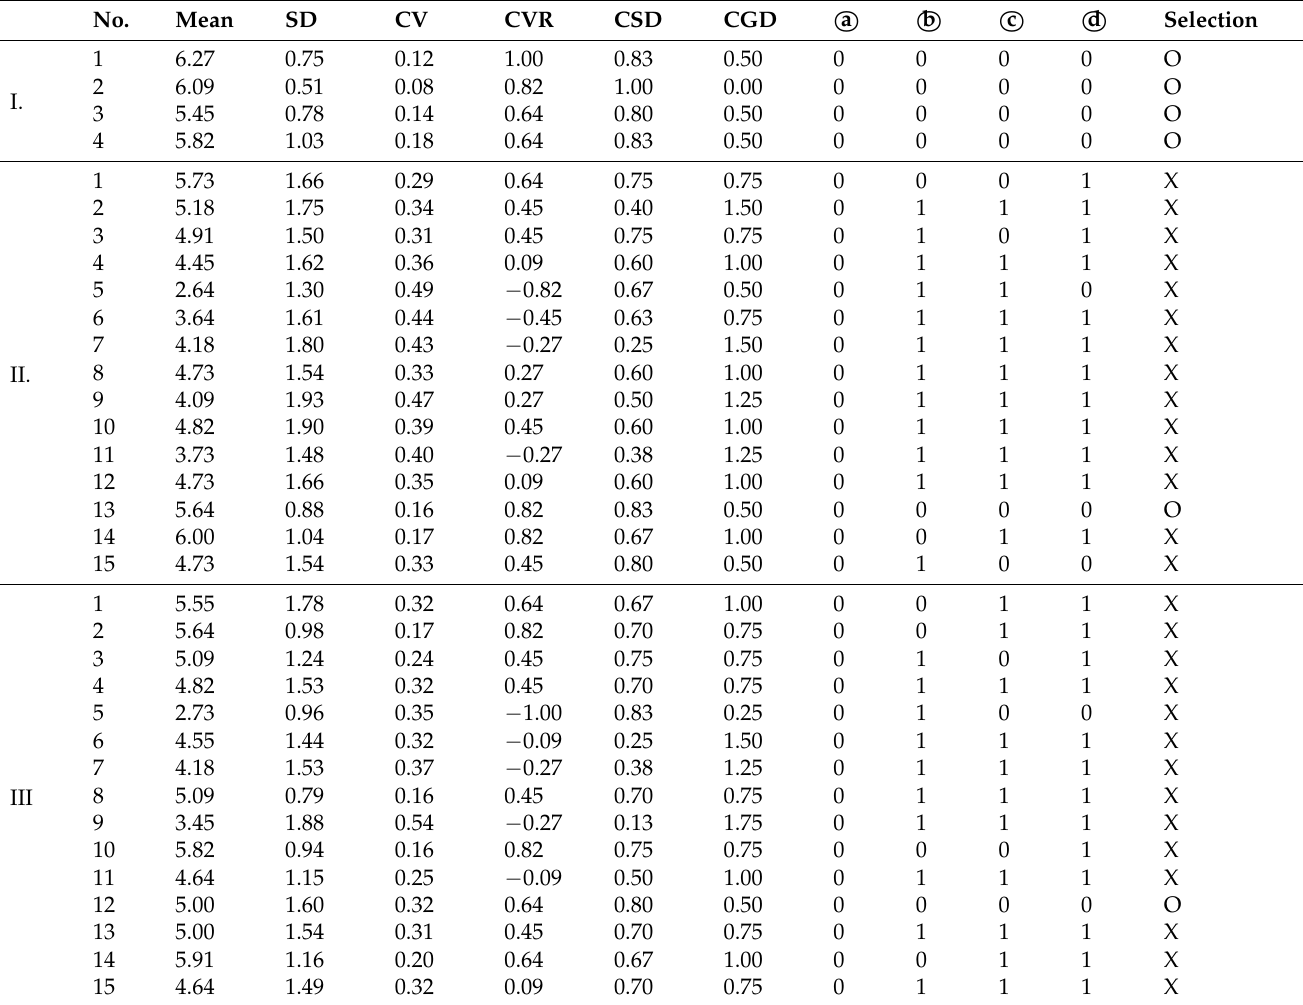
Table 6. First conformity assessment